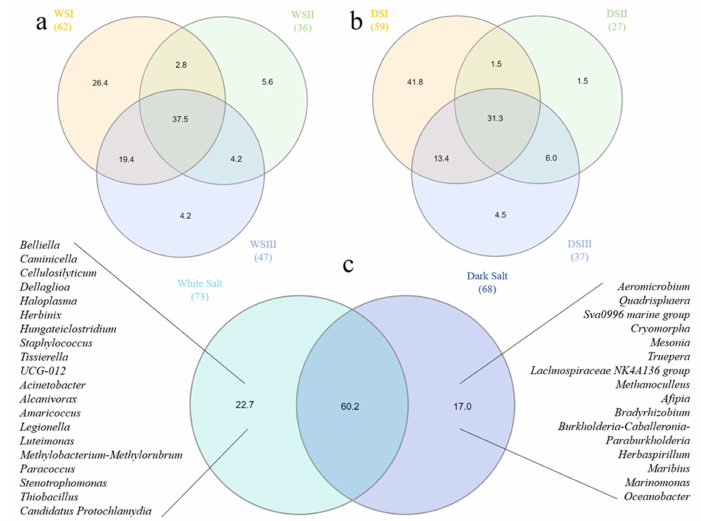
Figure 9. Venn diagram depicting the sharing level of genera retrieved in the total bacterial communities of salt samples. ( a ) WS versus WS ; ( b ) DS versus DS; ( c ) WS versus DS . WS , white salt; DS , dark salt.